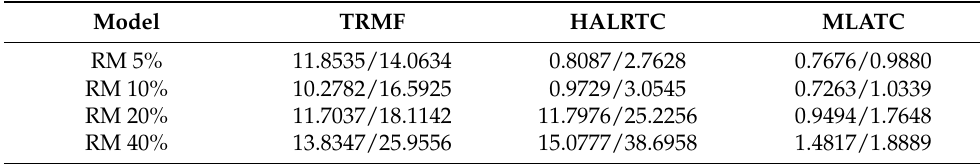
Table 2. Evaluation metrics for data completion in the RM case (MAPE/RMSE).